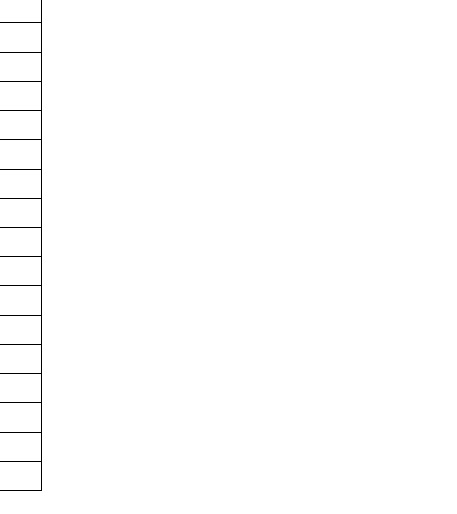
Table 2. Modified mankin histology